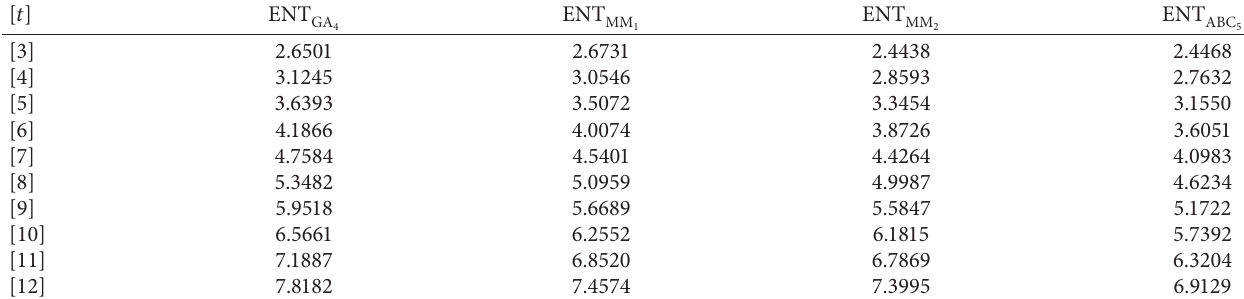
Table 9: Comparison of eccentricity-based entropies ENT